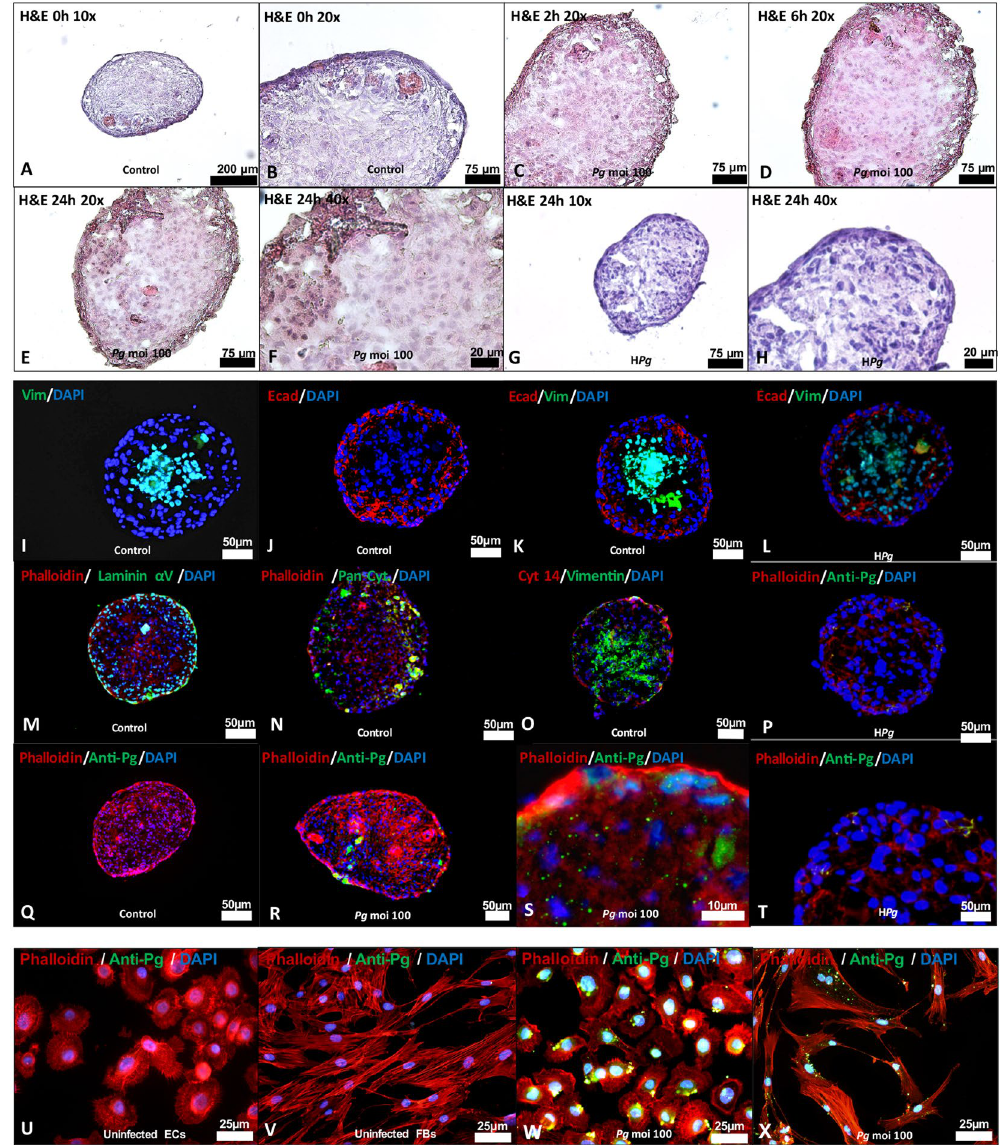
Figure 2. Morphological characteristics of MT spheroids mimicking gingival soft tissues. ( A – H ) Histological hematoxylin-eosin images under optic microscopy at 0, 2, 6 and 24 h at different magnifications (10x: A , G ; 20x: B , C , D , E ; 40x: F , H ) of uninfected MTs ( A , B ), of MTs infected with P. gingivalis ( C – F ) and heat-inactivated P. gingivalis ( G , H ). ( I – L ) Immunofluorescence staining of uninfected MTs ( I – K ) and infected with heat-killed P. gingivalis ( L ) (Green: Vimentin, Red: E-cadherin, Blue: DAPI – nuclear staining-) (20x magnification). ( M – O ) Immunofluorescence staining of uninfected MTs (Green: Laminin α 5; Pan Cytokeratin; Vimentin, Red: E-cadherin, Cytokeratin 14, Blue: DAPI – nuclear staining-) (20x magnification). ( P – T ) Immunofluorescence staining of uninfected, infected with P. gingivalis and heat-killed P. gingivalis infected MTs (Green: P. gingivalis immunostaining, Red: Phalloidin, Blue: DAPI – nuclear staining). ( U – X ) Immunofluorescence staining of uninfected, infected with P. gingivalis and heat-killed P. gingivalis infected ECs and FBs (Green: P. gingivalis immunostaining, Red: Phalloidin, Blue: DAPI – nuclear staining). Magnification was 20x for I-R and 40x for ( S – X